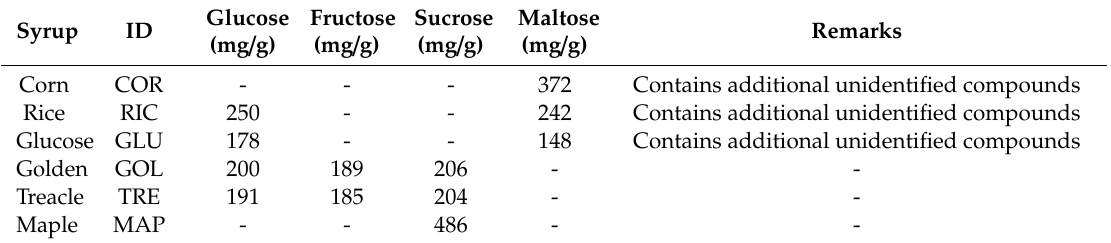
Table 2. Glucose, fructose, sucrose and maltose content of syrups 1 .